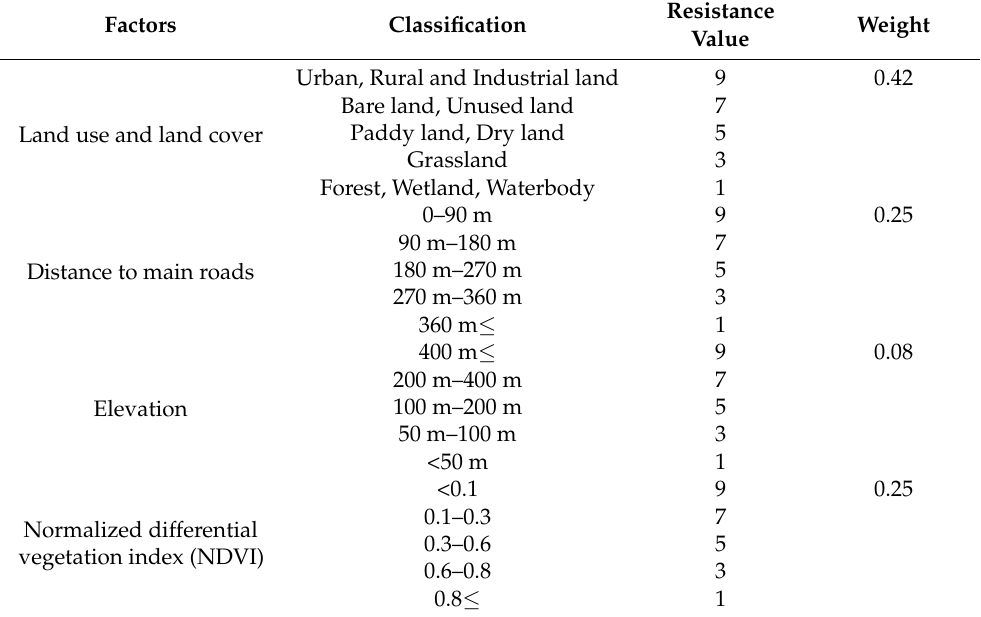
Table 2. Resistance value assignment in LCPs